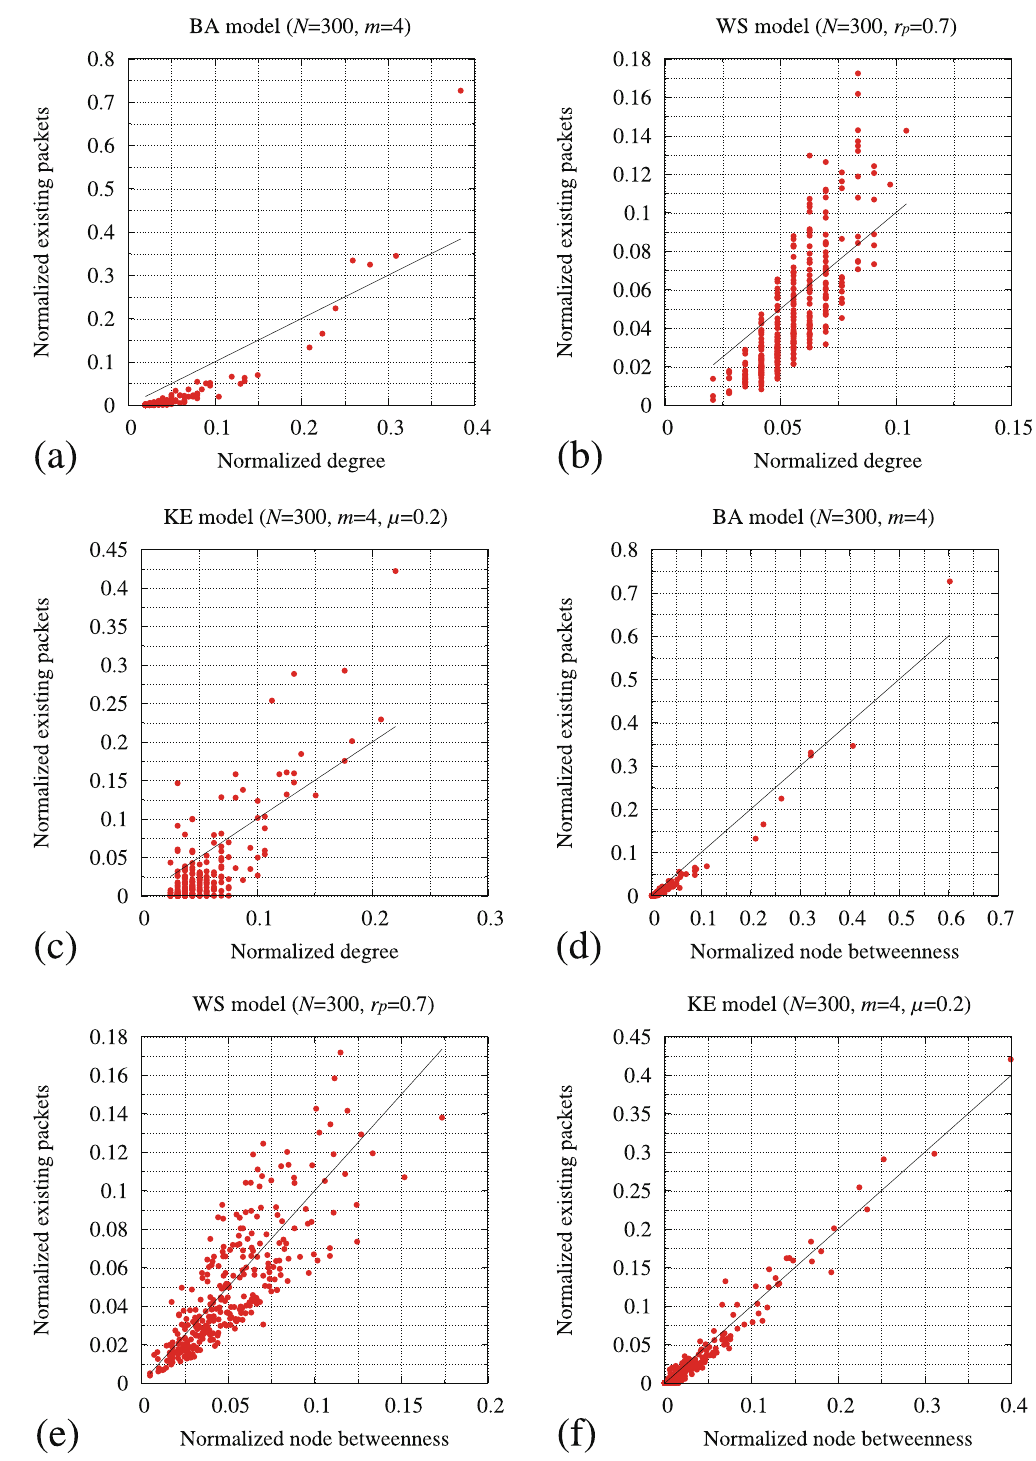
Fig 1. Upper figures : scatter plots of the normalized degree centrality of networks and normalized the number of existing packets generated by the SP method for the (a) BA, (b) WS, and (c) KE models. Lower figures : scatter plots of the normalized betweenness centrality of networks and normalized the number of existing packets generated by the SP method for the (d) BA, (e) WS, and (f) KE models. Black lines in all figures represent f ( x ) = x .